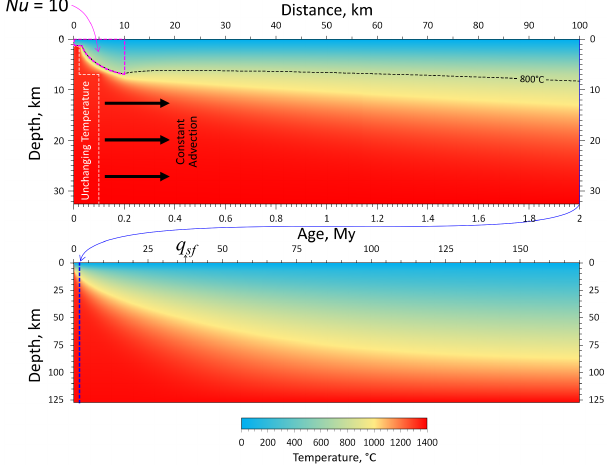
Figure 3. Boundary and initial conditions for models GH and GHC. The temperature in the region outlined in white dashes varies with depth but remains constant over horizontal distance. The distance between the surface and the top of the axial boundary condition is 1.4km. All material around this space migrates at a constant rate away from the ridge axis. The top figure shows the boundary condi- tions of the 2-D part of the model (0–2My), and the bottom figure shows the conditions of the 1-D part of the model (2–170My). After Fig. 2 in Grose and Afonso